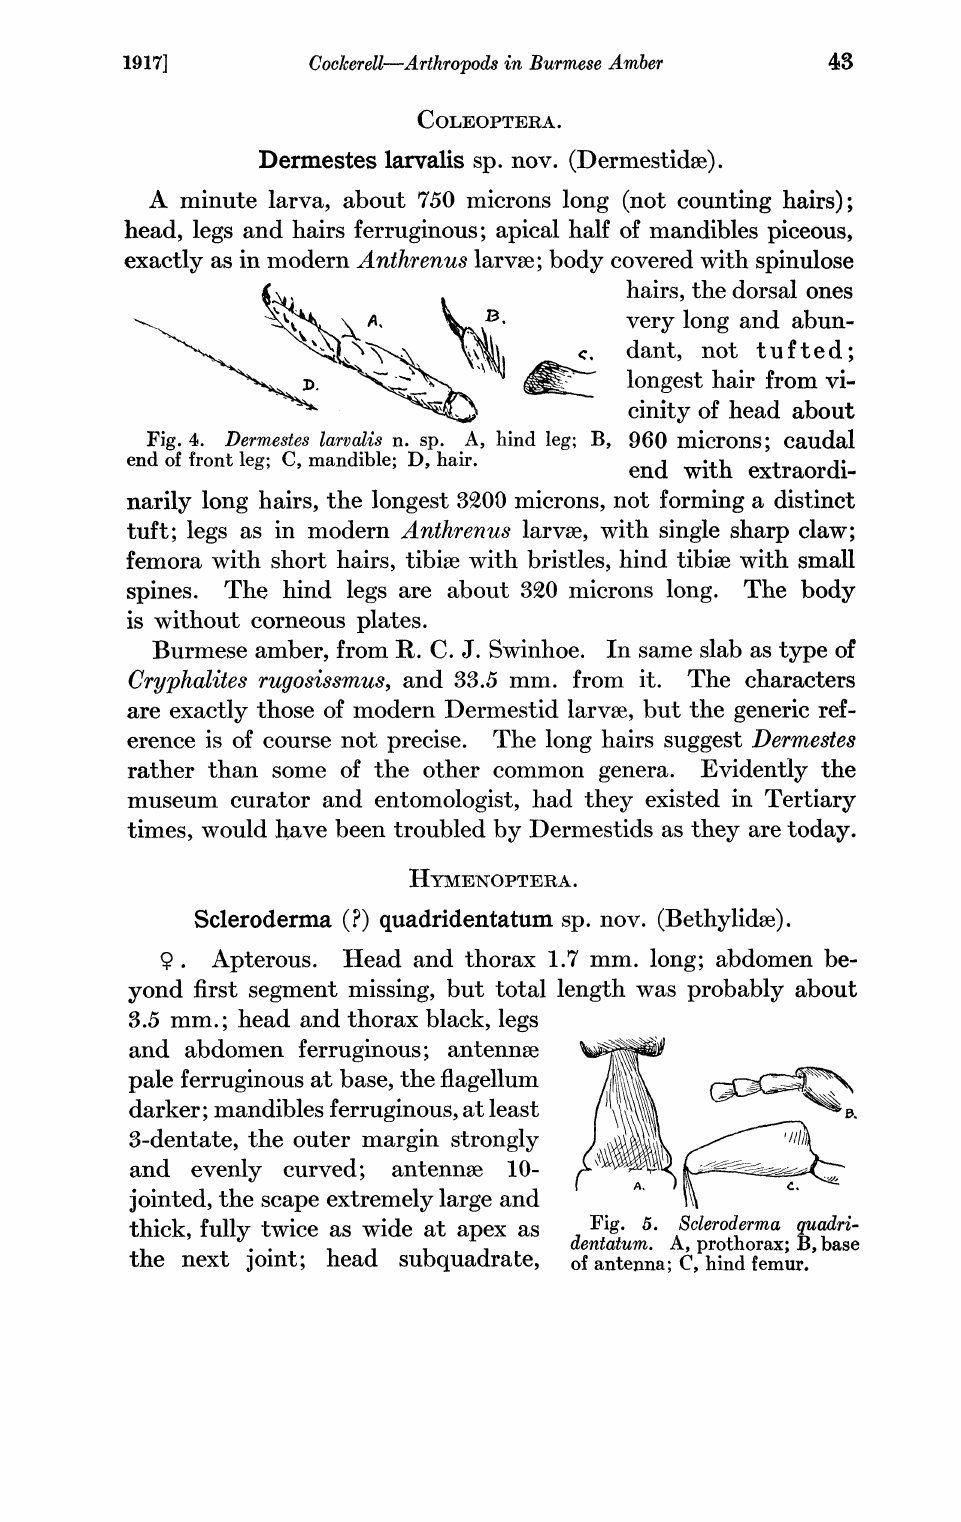
Fig. 5. Scleroderma quadri- dentatum. A, prothorax; B, base of antenna; C, hind